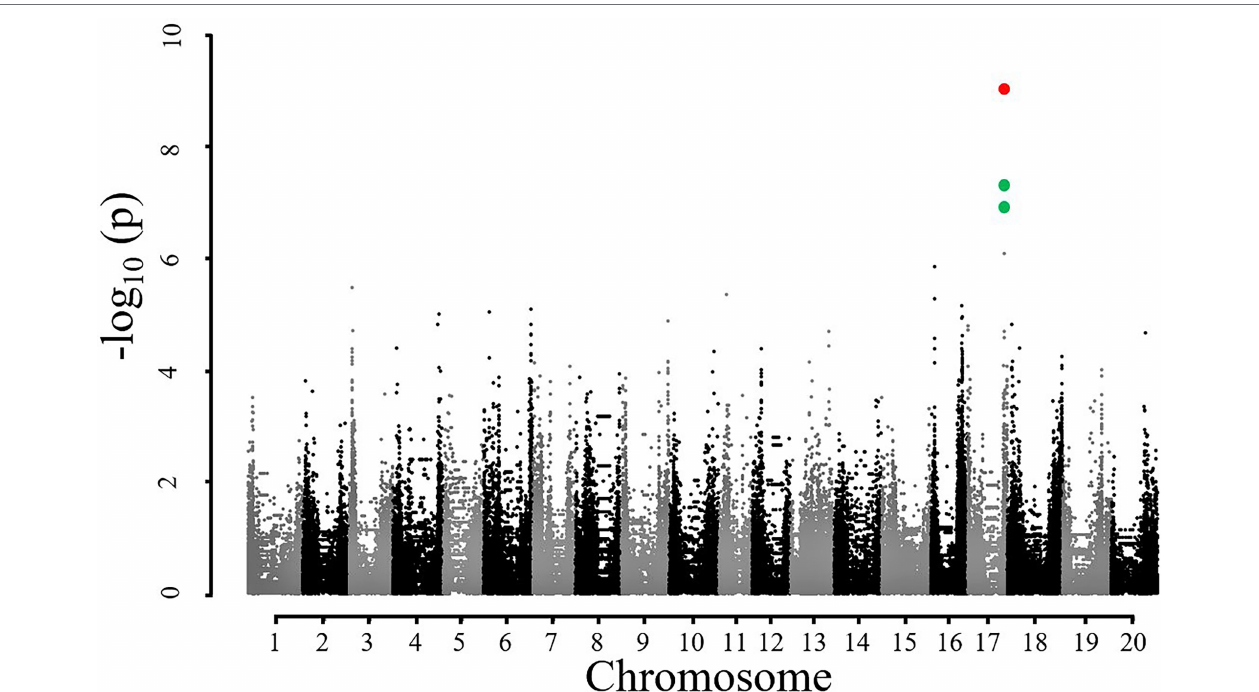
FIGURE 4 | Manhattan plot for showing significant association of SNPs with SNE2. Red and green dots on chromosome 17 represent significant and suggestive associations where –log ( p ) value is less than 8 and 5,